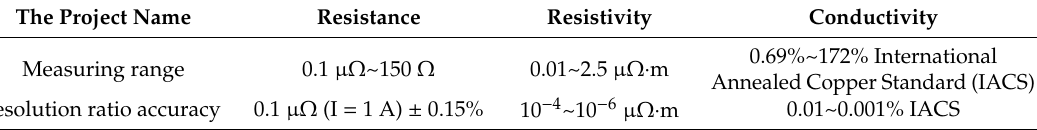
Figure 3. The specimen for testing conductivity.